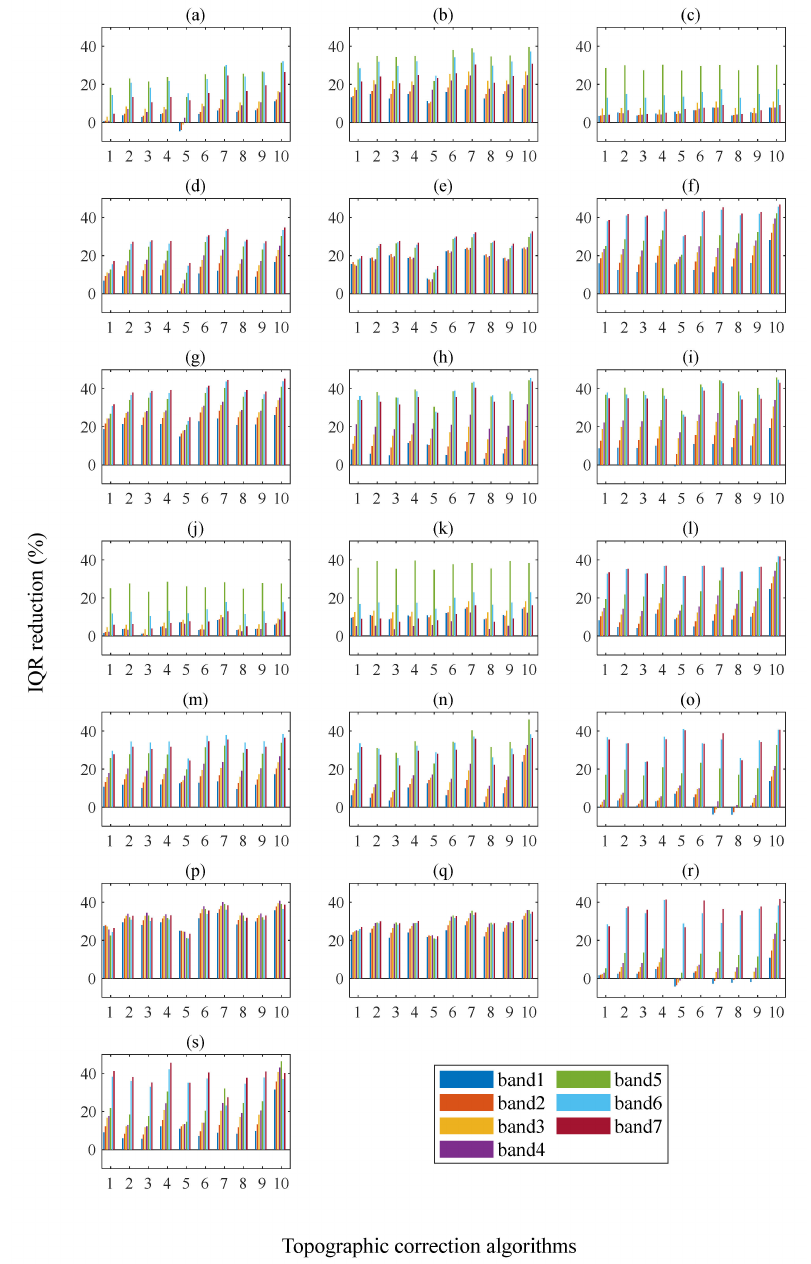
Figure 7. The comparison of IQR reduction in January/November. The x label number represents different algorithms: b correction, SCS+C, C, Minnaert+SCS, PLC, VECA, Teillet regression, C with land type stratification, SCS+C with land type stratification, and Teillet regression with land type stratification. ( a ) 120,039 (path/row) image obtained on 20170126, ( b ) 120,039 image obtained on 20181129, ( c ) 121,042 image obtained on 20171101, ( d ) 122,035 image obtained on 20180111, ( e ) 122,035 image obtained on 20171124, ( f ) 124,032 image obtained on 20170122, ( g ) 124,032 image obtained on 20181109, ( h ) 128,036 image obtained on 20170102, ( i ) 128,036 image obtained on 20181121, ( j ) 129,043 image obtained on 20180128, ( k ) 129,043 image obtained on 20161122, ( l ) 131,035 image obtained on 20180110, ( m ) 131,035 image obtained on 20171107, ( n ) 131,038 image obtained on 20180126, ( o ) 131,038 image obtained on 20,181,110 ( p ) 139,040 image obtained on 20180118, ( q ) 139,040 image obtained on 20181118, ( r ) 143,030 image obtained on 20180130, ( s ) 143,030 image obtained on